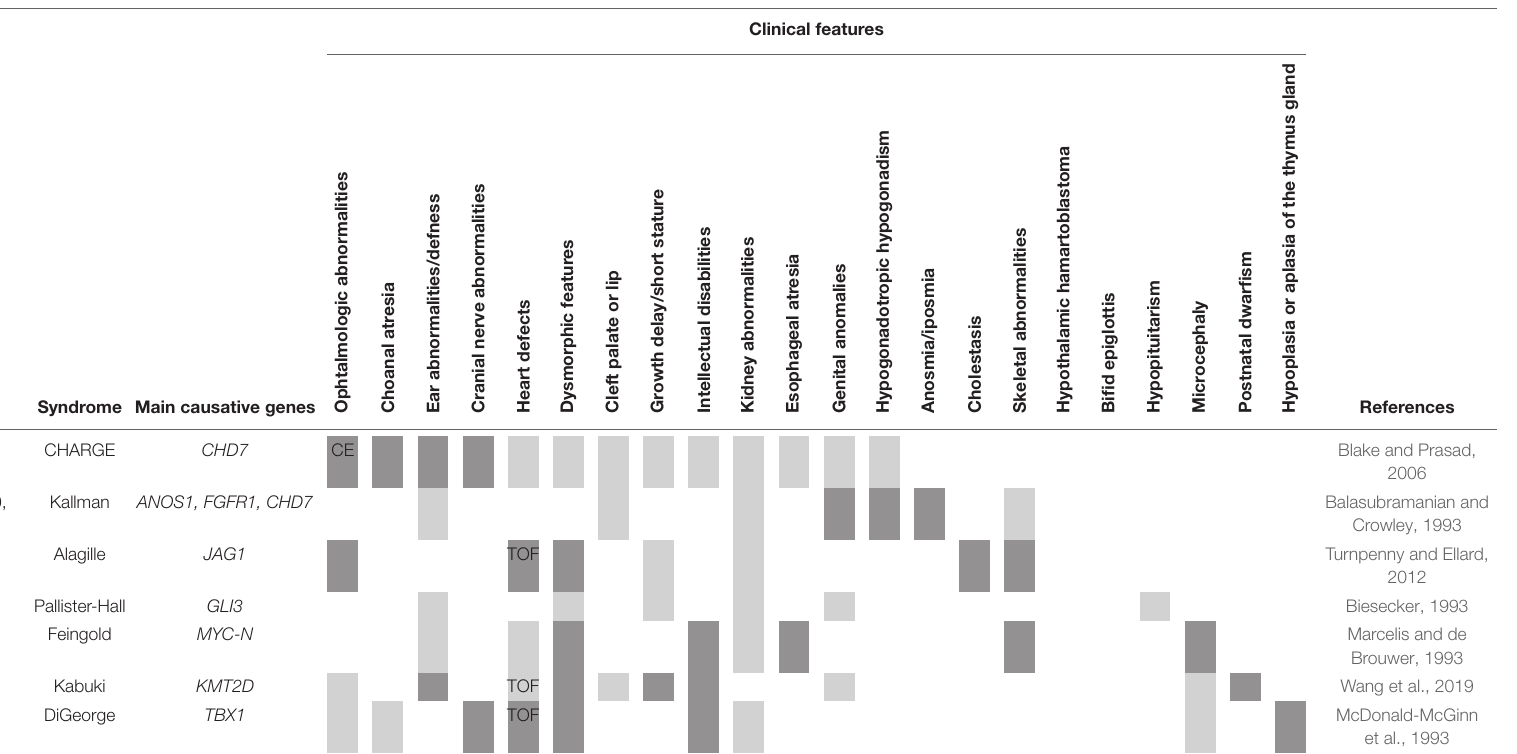
TABLE 1 | Different syndromes as discussed in the text, the main mutated genes, and the characteristic clinical features.